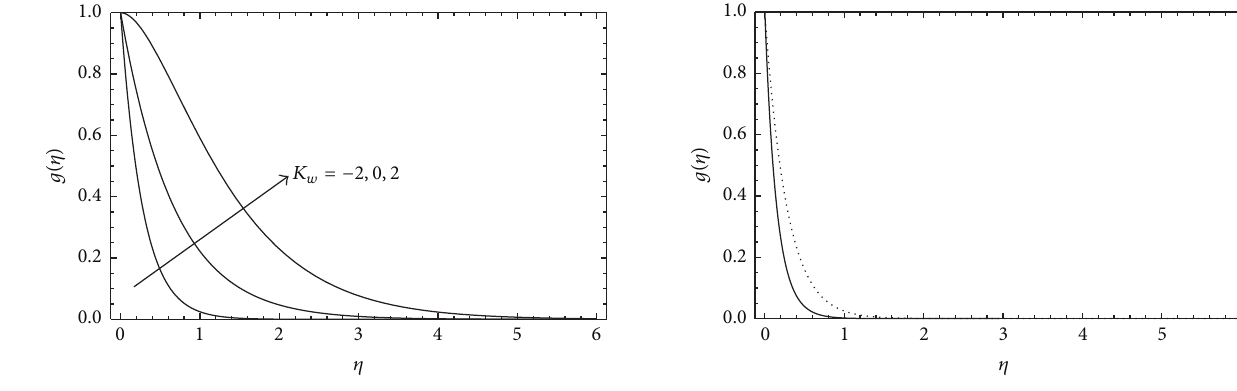
Figure 9: Variation of temperature profiles with 𝐾 𝑤 (= −2, 0, 2) for 𝑀 = 𝑁 = 1, Pr = 0.7 .